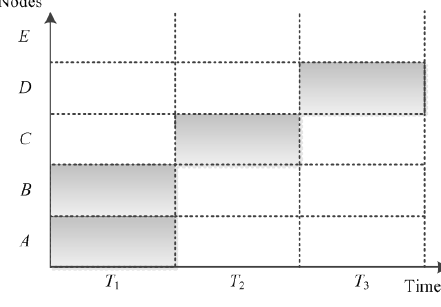
Fig. 2. The TDMA schedule in a cluster.